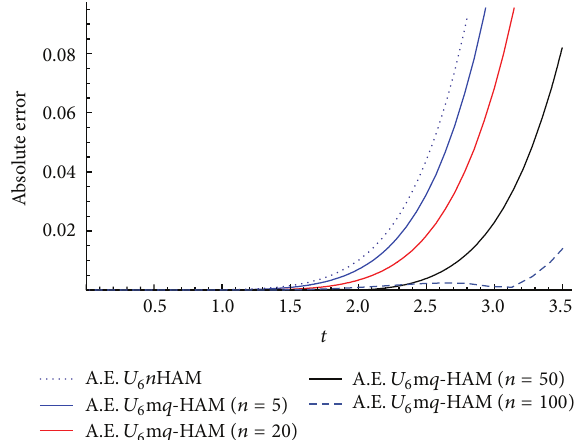
Figure 15: The comparison between the absolute error of 𝑈 3 and 𝑛 HAM (m 𝑞 -HAM ; 𝑛 = 1) of (40) at ℎ = −1 , 𝑥 = 1 , and 𝑈 6 of 0 ≤ 𝑡 ≤ 3.5 .